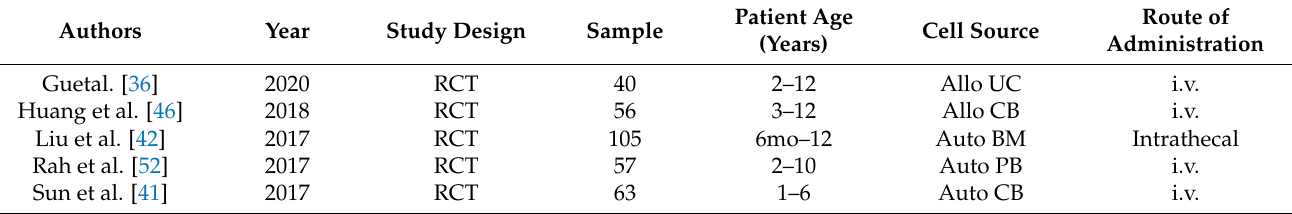
Table 7. Clinical trials of cell therapies in